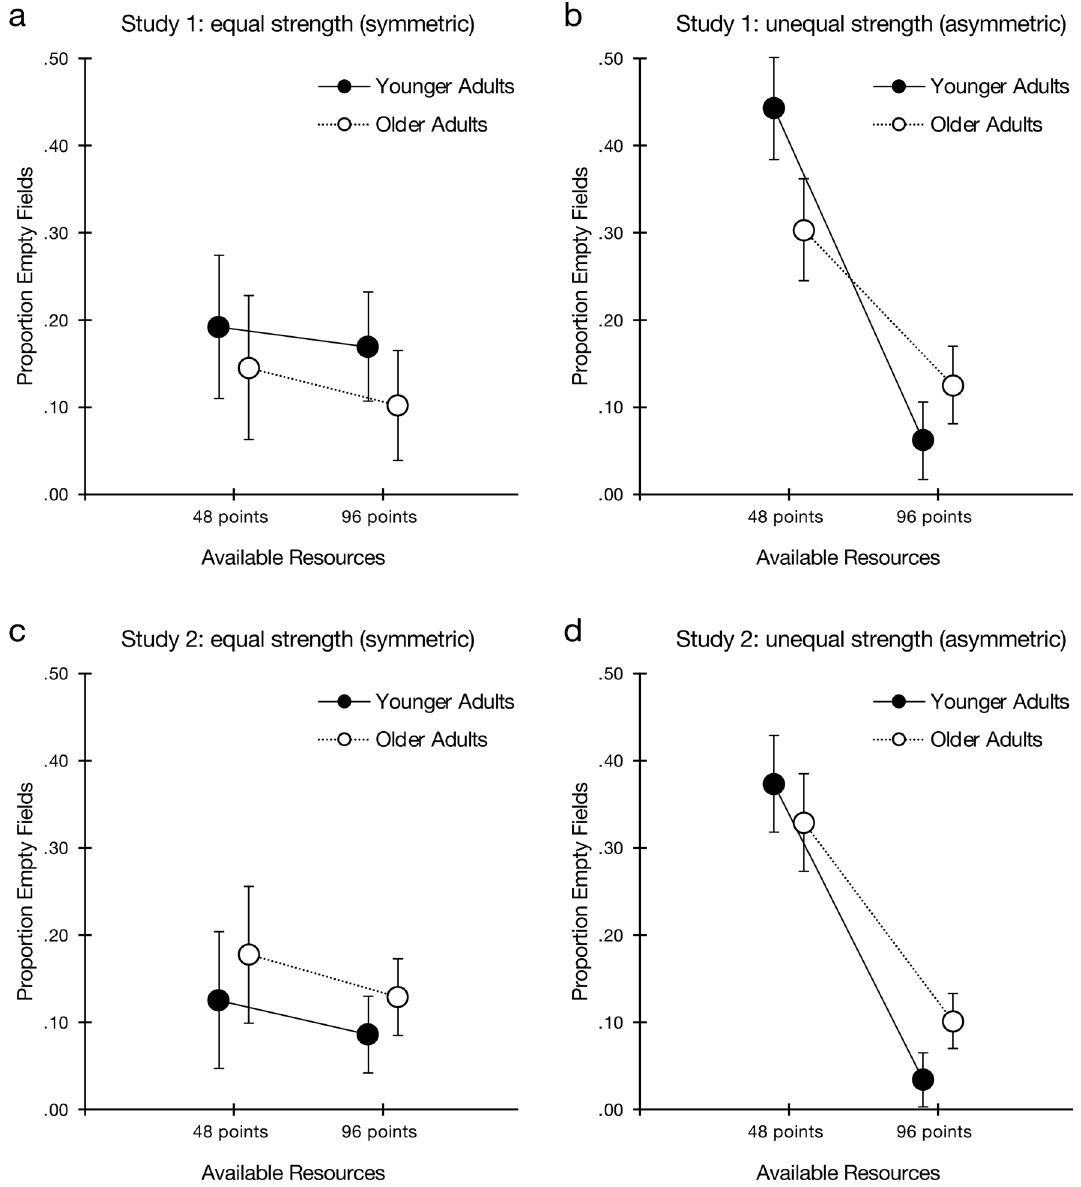
Figure 3. Strategic allocations (mean proportion of fields left empty) by younger and older adults in the Colonel Blotto game as a function of available resources in symmetric and asymmetric competition. Error bars represent 95%